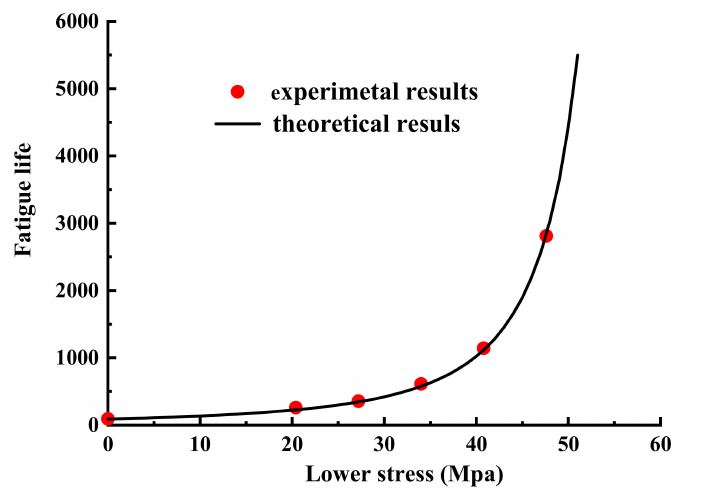
Figure 10. Variation law of fatigue life of sandstone samples with lower limit stress when the upper limit stress is fixed ( σ max = 61.2 Mpa).